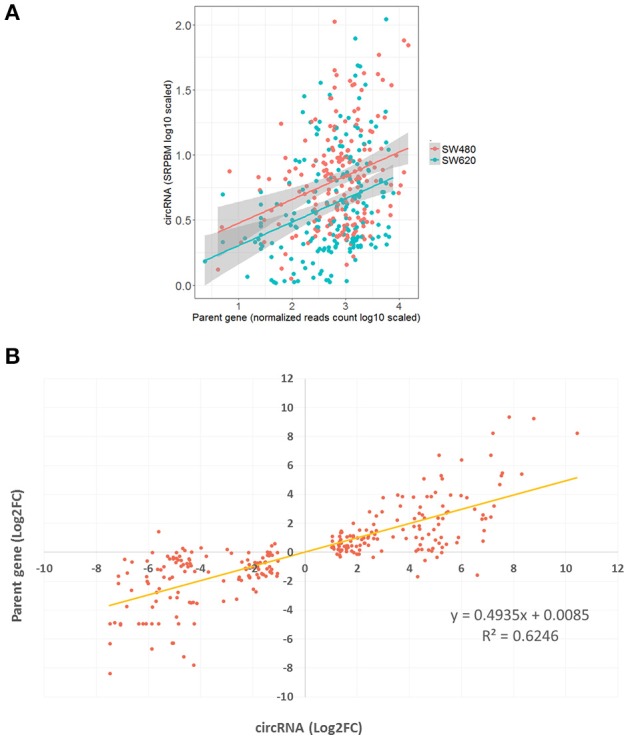
Positive relationship of expression between pmDECs and their host genes. (A) Expressions on log-scale of the 277 pmDECs and their host genes from SW480 and SW620 cell lines. (B) Equation of linear regression of fold-changes on log2-scale of the 277 pmDECs and their host genes between SW480 and SW620.